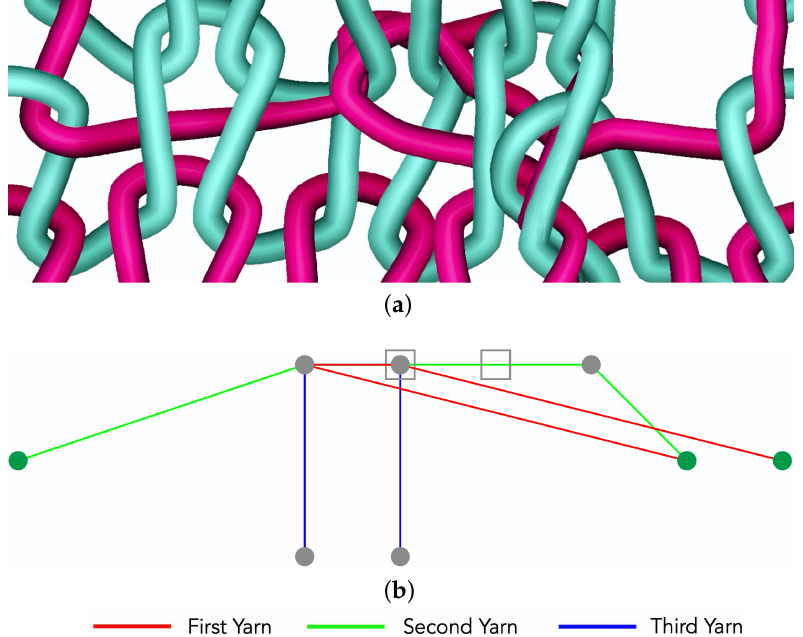
Figure 18. Yarn order zoom-in at location (5, 3) in the yarn topology graph of Figure 17: ( a ) Simulated knitted pattern. ( b ) Corresponding zoom-in topology